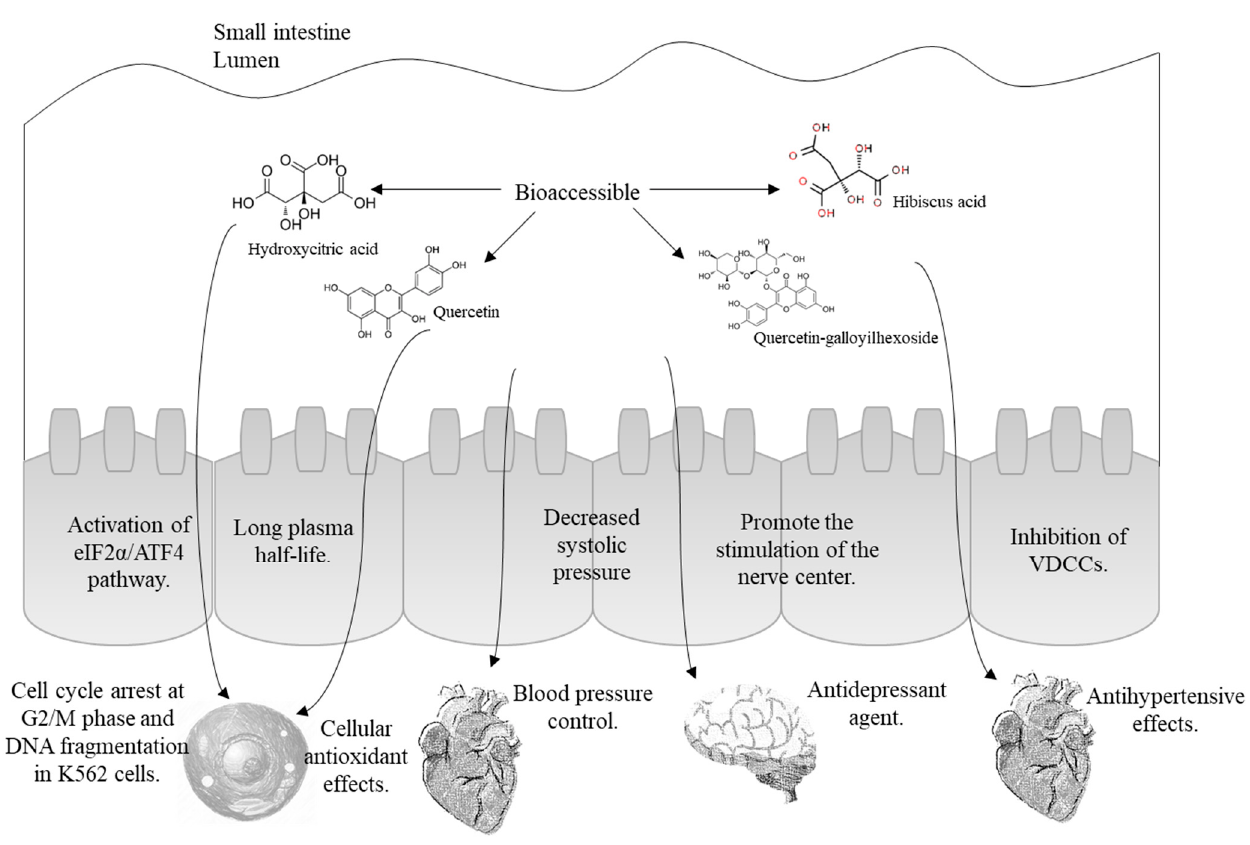
Figure 4. Potential health effects of the main bioactive compounds from the Hibiscus beverage.